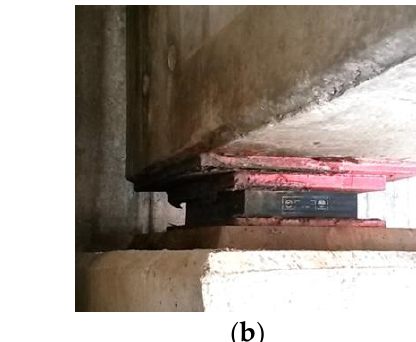
Figure 1. Configuration of bearing support: ( a ) Concept figure; ( b ) Schematic diagram.